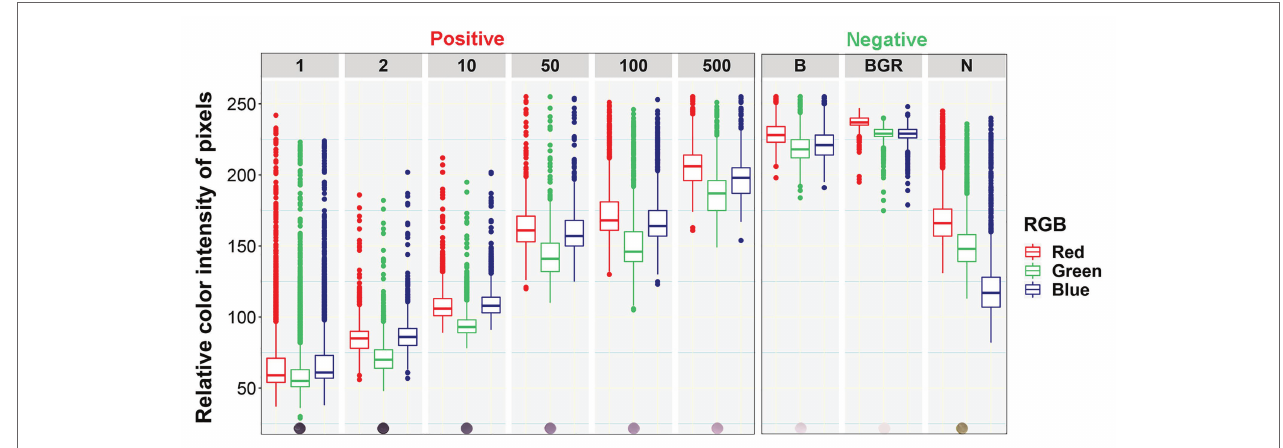
FIGURE 3 | Box plots of relative color intensity of prototypic blot pixels of different categories. Numbers above the plots indicate the undiluted status (1) or dilutions of the positive control (1:2, 1:10, 1:50, 1:100, and 1:500), while letters indicate the Buffer alone (B), background area around the dots (BGR), and Negative (N)